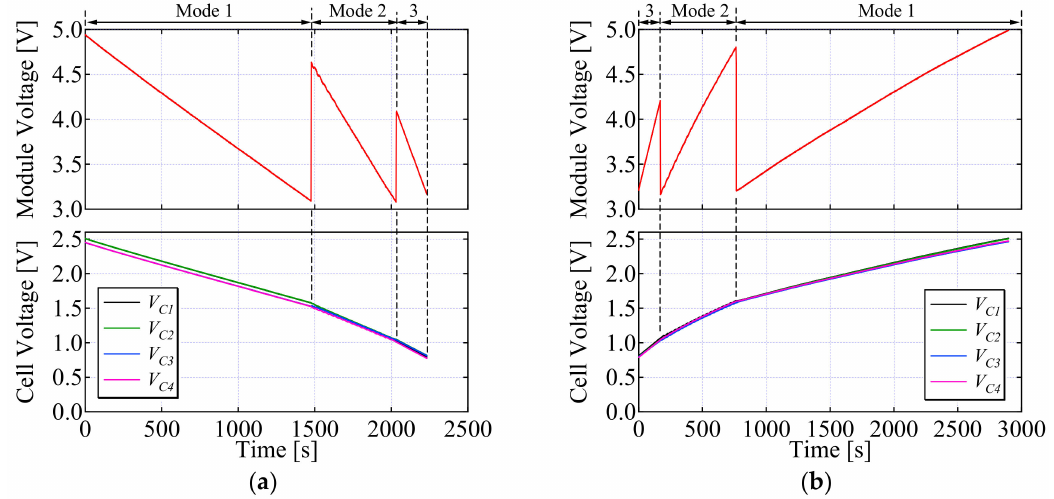
Figure 14. Experimental results. ( a ) Discharging profiles and ( b ) charging profiles.